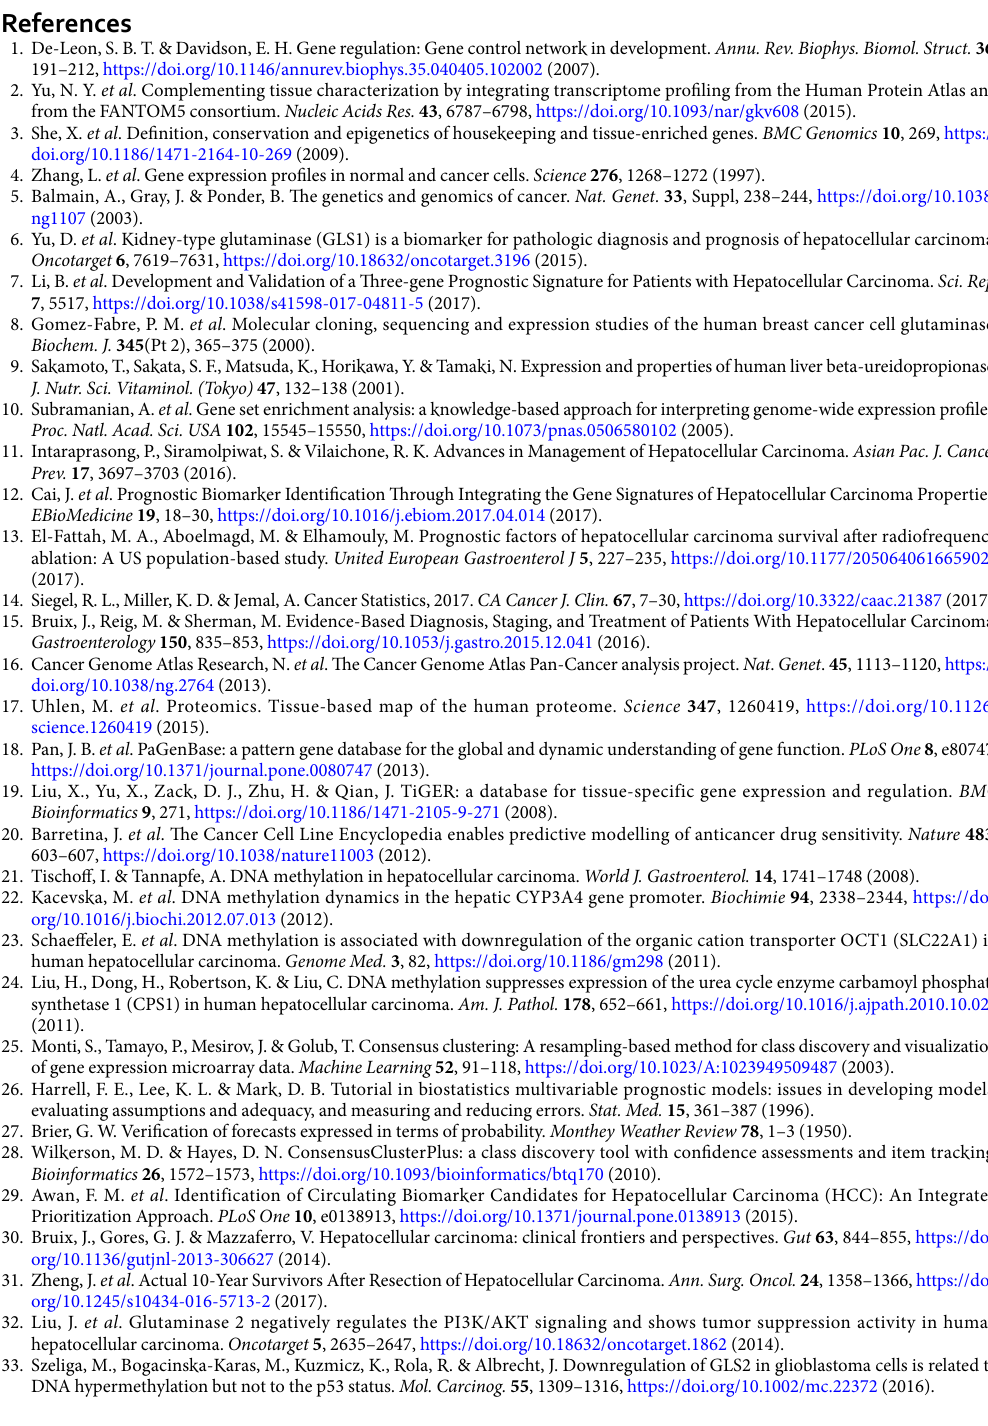
sorted according to increasing med and divided equally into two or three groups. The mean expression distance was considered as “risk score”, and the Concordance index(C-index) 26 , Brier score 27 and time-dependent receiver operating characteristic (ROC) curve were used to evaluate the accuracy of survival prediction of the mean expression distance. The C-index was calculated using the function concordance. index and the Brier score was calculated with the function sbrier.score2proba in the R survcomp package 46 . The time-dependent ROC curves were generated from the function survivalROC in the R survivalROC package 47